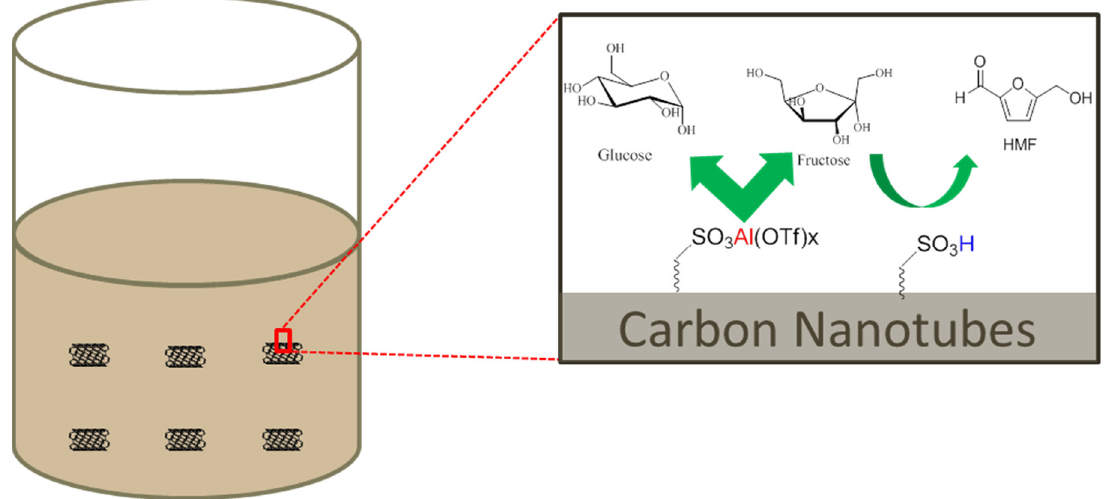
Figure 1. Solid Lewis/Brønsted acid catalysts for hydroxymethylfurfural (HMF) production from C 6 sugars.